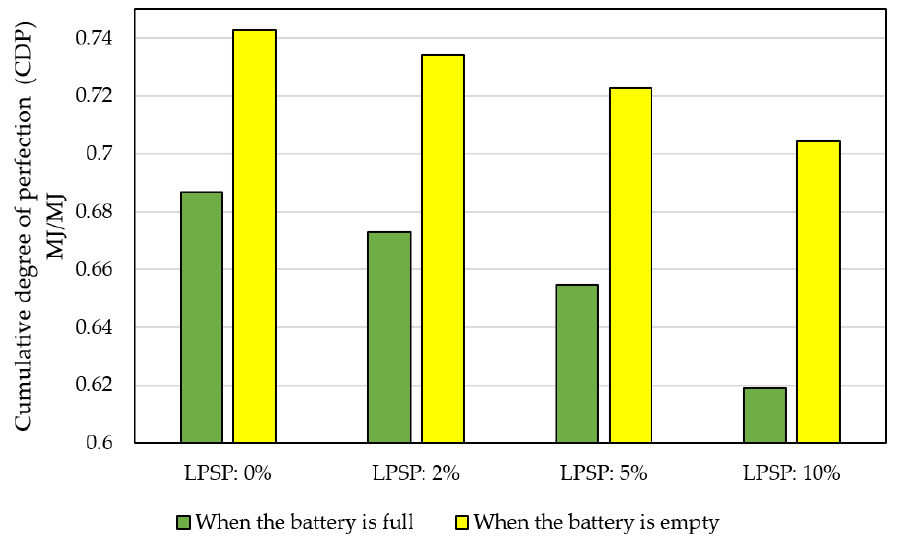
Figure 8. Cumulative degree of perfection in freshwater production by SWROD/WT/BBS based on different LPSP (%) (FU = 1 m 3 ).